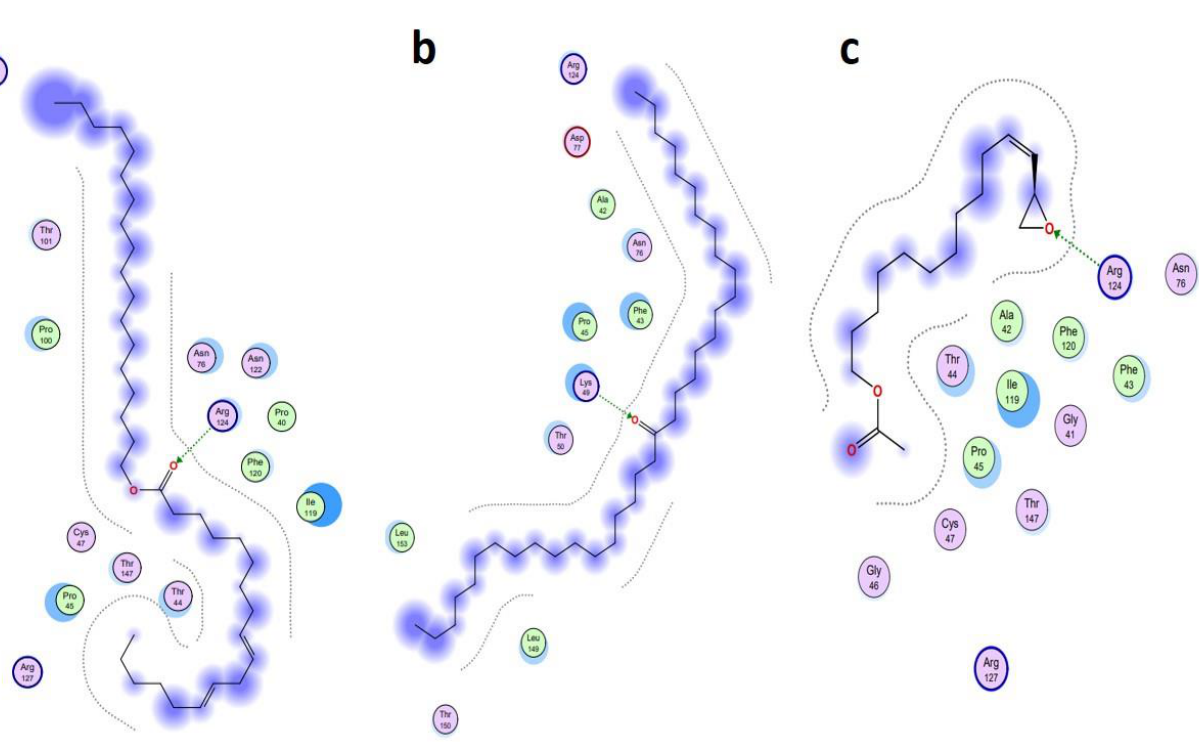
Figure 8. Hydrogen bonding capacity of top three scored docked ligands CID_ 22287839 ( a ), CID_10440 ( b ), and CID_5363633 ( c ), within the active site of antioxidant protein [PDB ID: 1HD2]. Purple colored area presents the hydrogen bond donor capacity and the green colored area presents the hydrogen bond acceptor capacity.